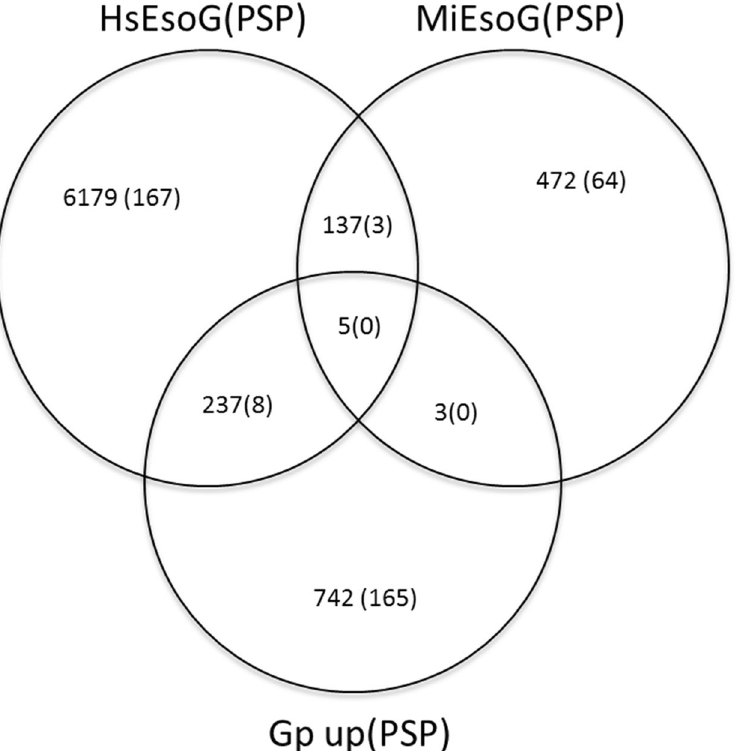
Figure 3. Venn diagram depicting the overlapping esophageal gland related sequences among H. schachtii , M. incognita and G. pallida . Numbers are representing protein sequences and numbers in parenthesis are the number of putative secretory (PSP)